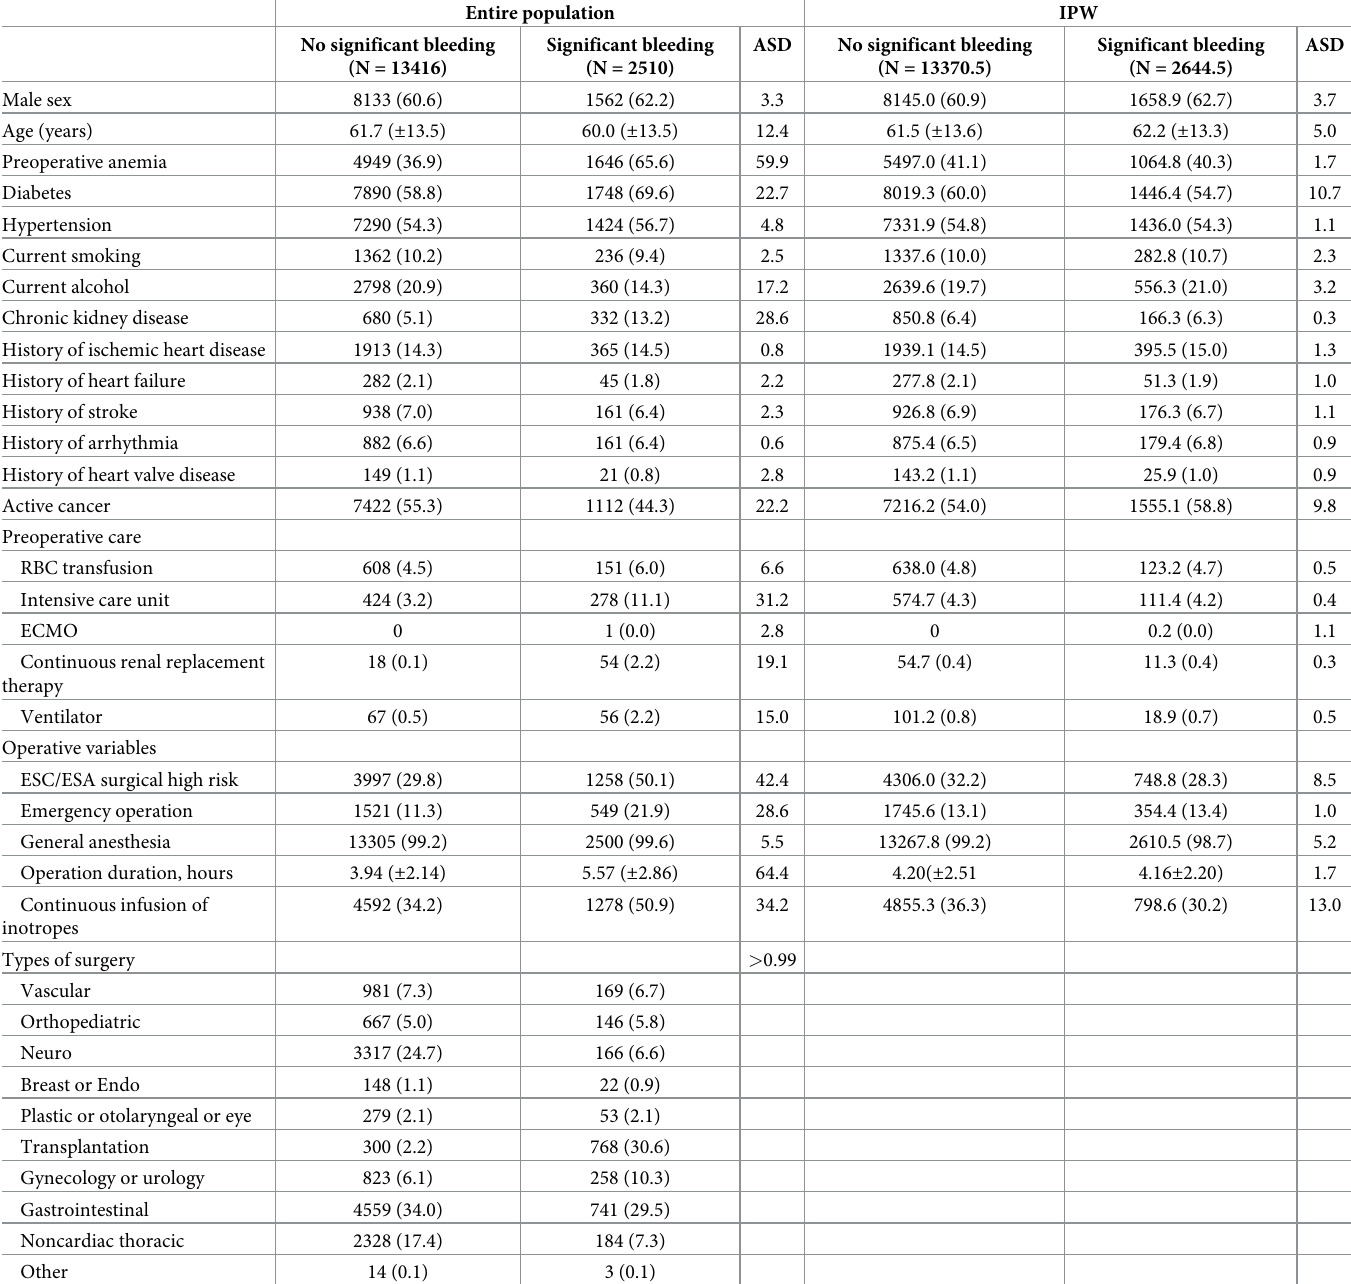
Table 1. Baseline characteristics according to significant intraoperative